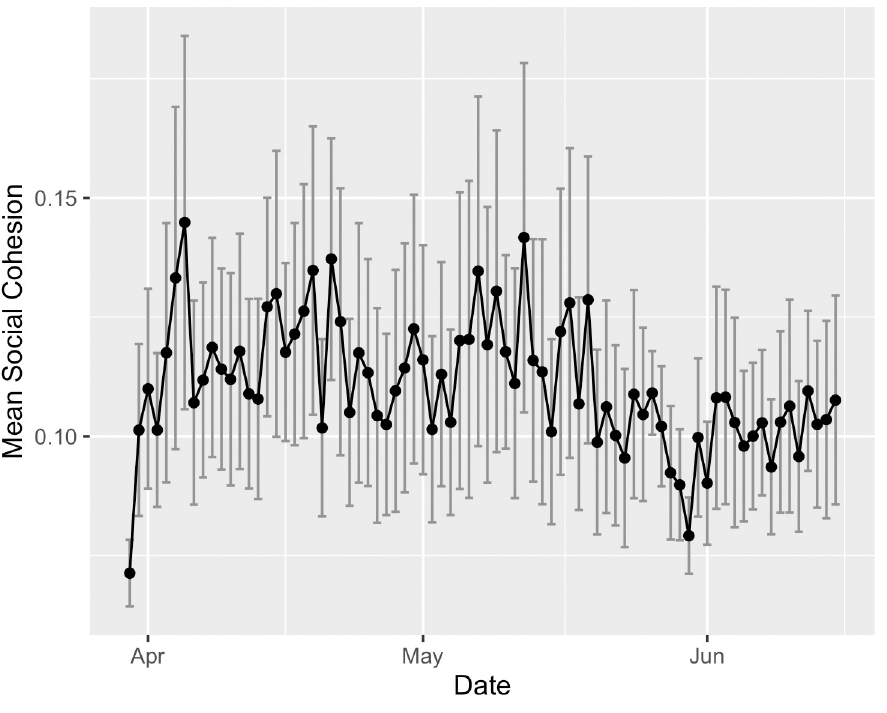
Fig 3. Raw social cohesion metric time